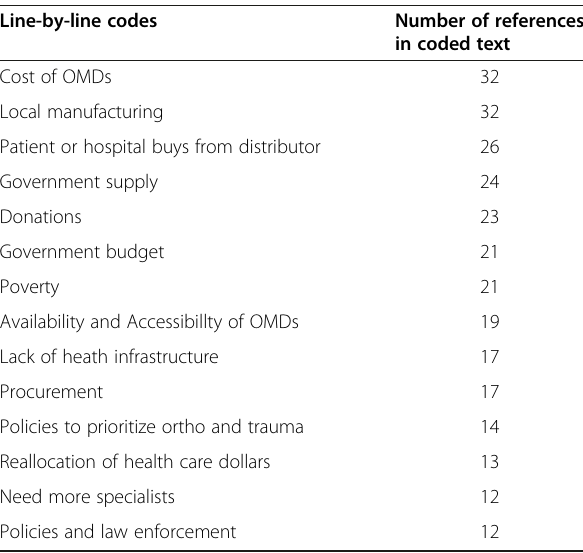
Table 2 Sample of preliminary codes and themes from interview